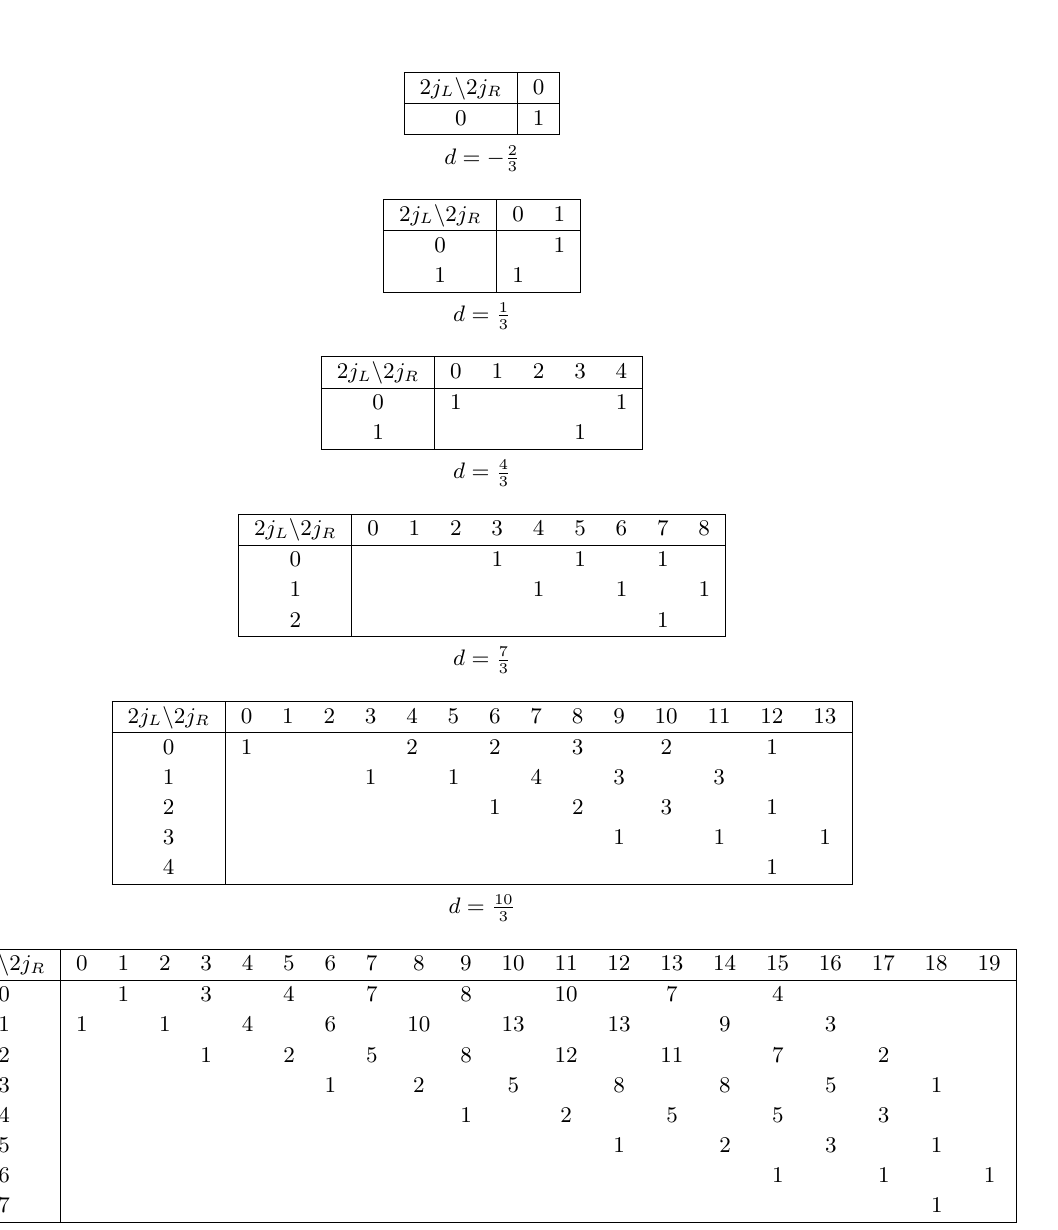
Table 16 . Pseudo-BPS spectrum of Wilson loop for local P 2 in the representation [ − 1] ⊗ [ − 1] for the curve class dt